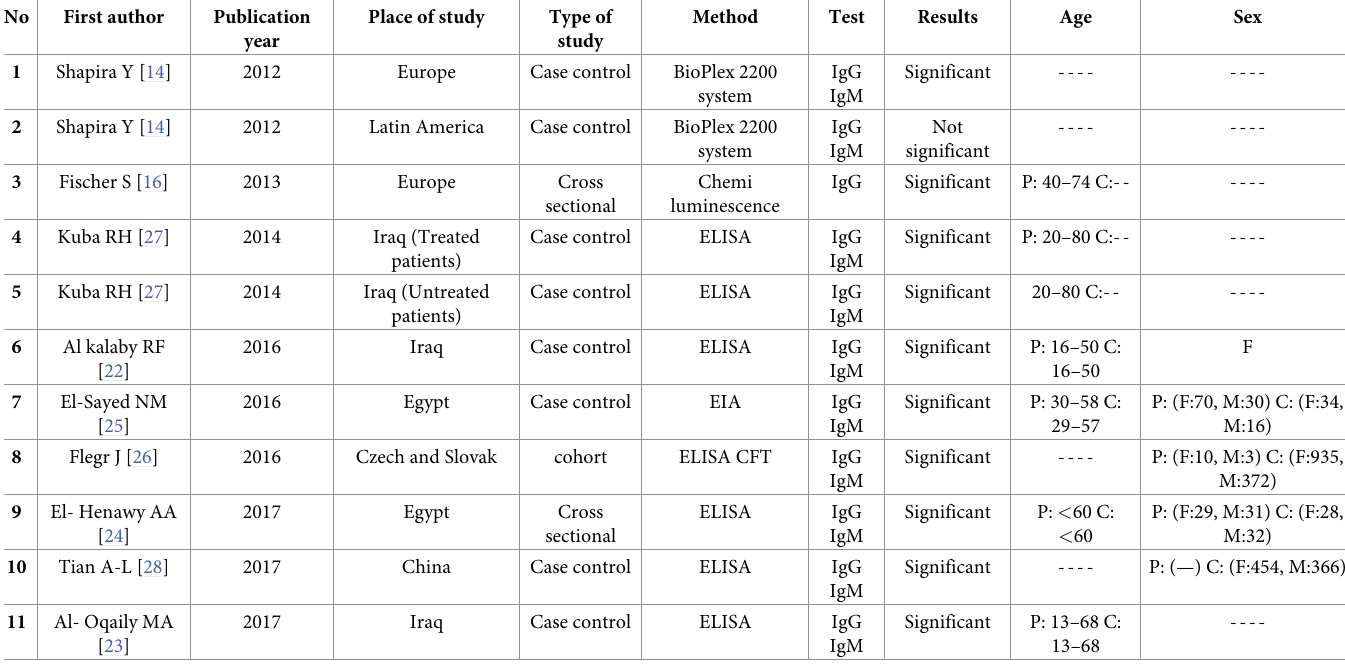
Table 1. Baseline characteristics of the included studies in the systematic review and meta-analysis of the relationship between T . gondii infection and RA